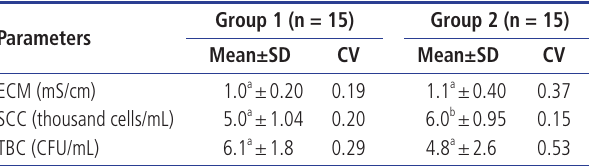
Table 6. Means and standard deviations in logarithmic scale, coeffcient of variation of cellularity parameters and total bacterial count of buffalo milk in groups at the beginning of lactation (1) and end of lactation (2)